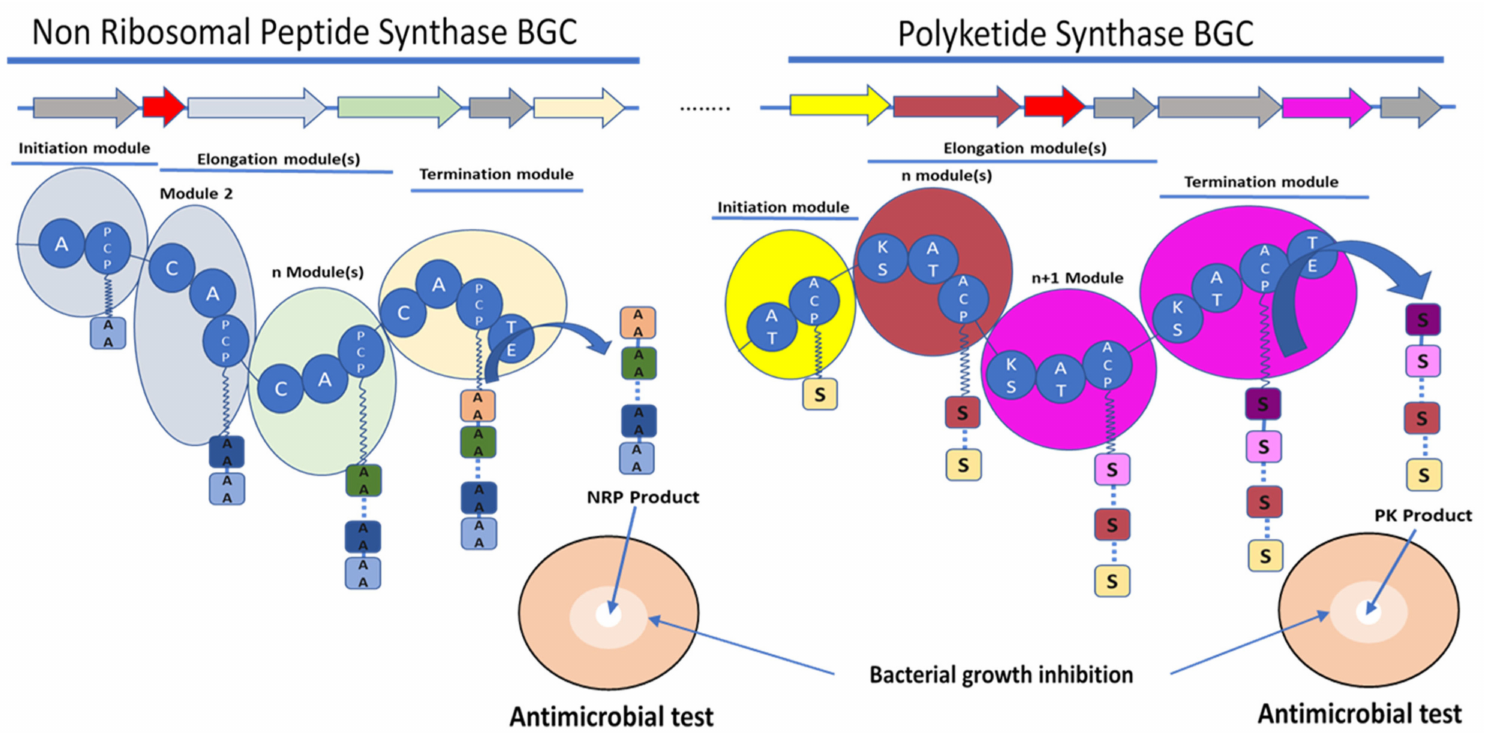
Figure 1. Schematic representation of the biosynthetic gene clusters (BGC) (arrows) and their encoded synthetase assembly lines (similarly coloured bubbles) involved in the biosynthesis of non-ribosomal peptide (NRP) and polyketide (PK) molecules. Non-ribosomal peptide synthase (NRPS) core domains are labelled as follow: A—adenylation domain, C—condensation domain, and PCP—peptidyl carrier protein. Polyketide synthase (PKS) core domains are labelled as follow: AT—acetylation domain, KS—ketosynthase, and ACP—acyl carrier